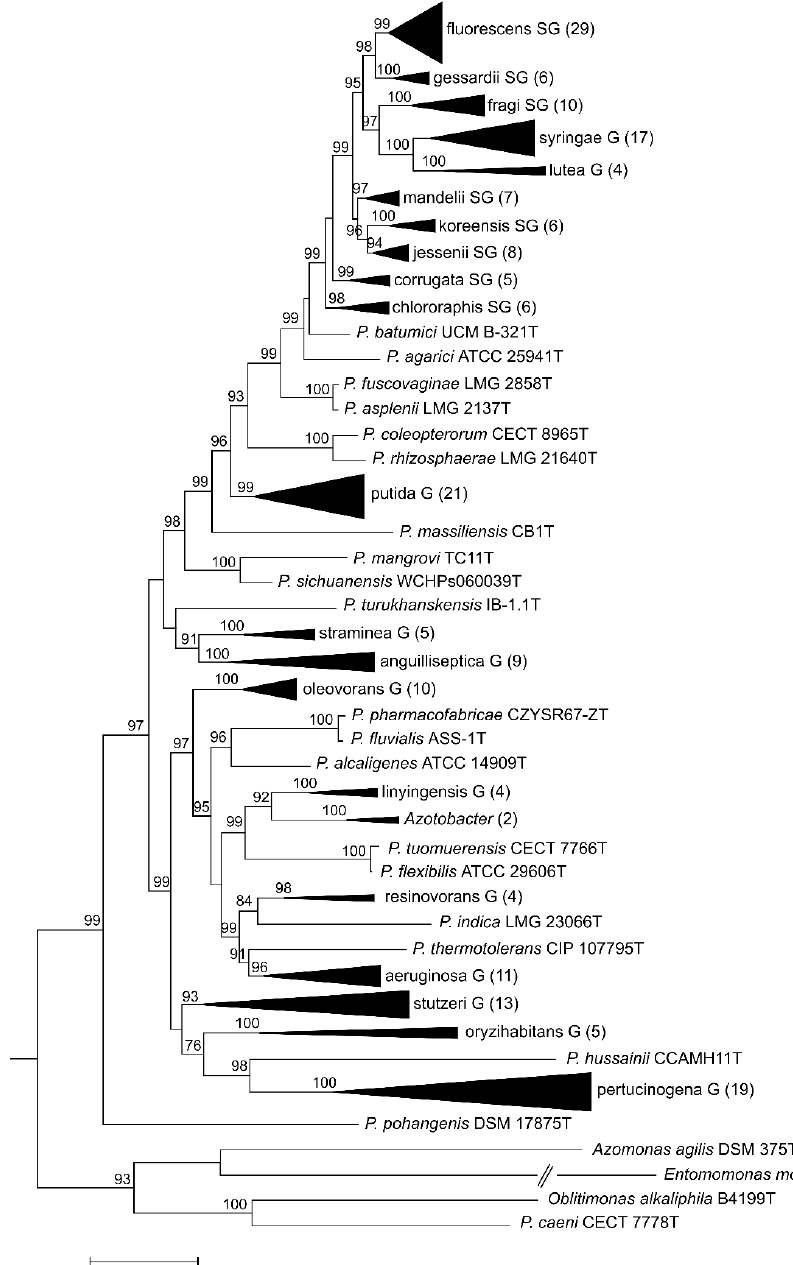
Figure 2. Maximum likelihood phylogenetic tree constructed with PhyML 3.0 based on the 4-genes MLSA for the di ff erent groups and subgroups defined in the Pseudomonas genus and closest-related genera. GTI + I + R was selected as the best evolutionary method. Number of species in each collapsed branch are indicated in brackets. Bootstrap values higher than 70% are indicated on the nodes. Bar indicates sequence divergence.